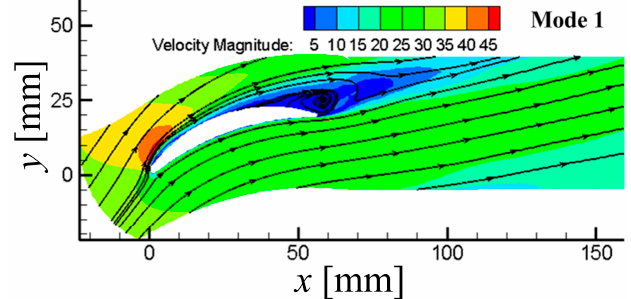
Figure 9. First mode of flow field by POD method.